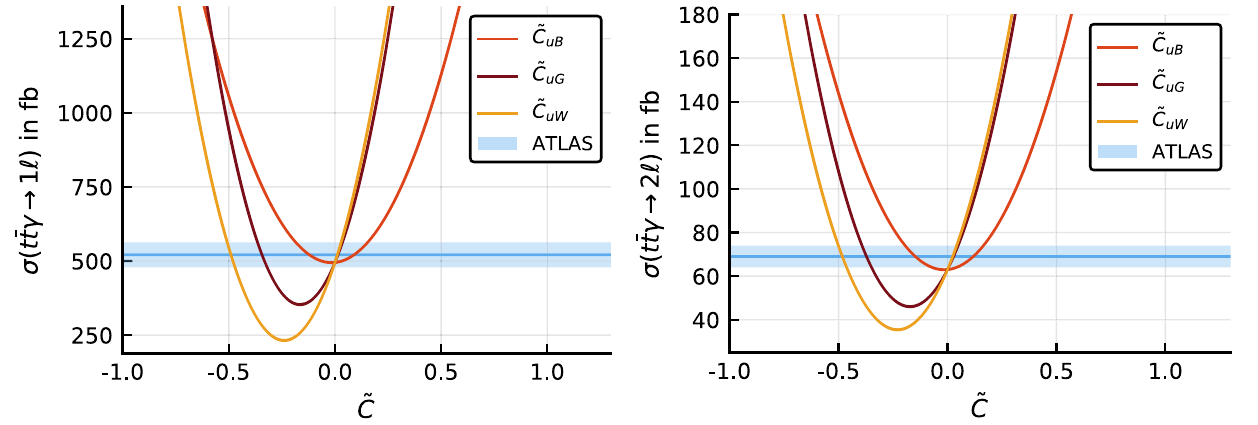
varied at a time, while the others are set to zero. Also indicated are the corresponding ATLAS measurements